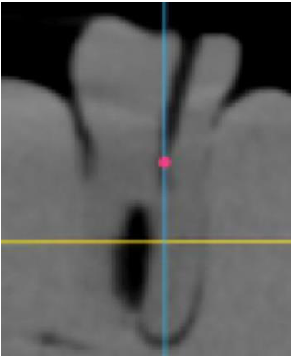
Figure 5. Example of a PEAC, showing a minimally invasive, direct straight-line access from occlusal surface to canal orifice.